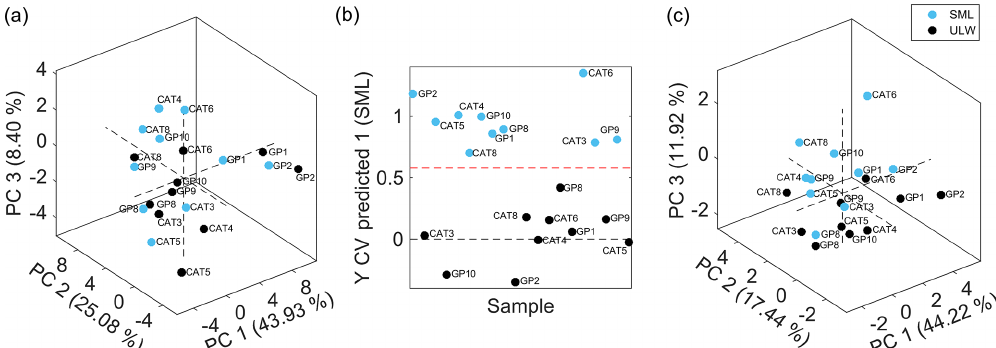
Figure 3. (a) PCA score plot showing the first three principal components of sea surface microlayer samples (SML, light blue) and ultralow seawater samples (ULW, black). PCA was done based on 51 extracted features with averaged values from technical replicates. Accounted variance: PC 1, 43.93%; PC 2, 25.08%; and PC 3, 8.40%. (b) Cross-validated (CV) prediction plot of orthogonal projections to latent structures discriminant analysis (OPLS-DA) model of SML samples (light blue) and ULW samples (black). The model consisted of 5 LVs with 82.19% and 95.41% total captured X-block and Y-block variances, respectively. The CV accuracy, sensitivity, and specificity were 100%. (c) PCA score plot showing the first three principal components of SML samples (light blue) and ULW samples (black). PCA was done based on 11 discriminant features selected by the genetic algorithm. Variance accounted for PC 1, 44.22%; PC 2, 17.44%; and PC 3, 11.92%.